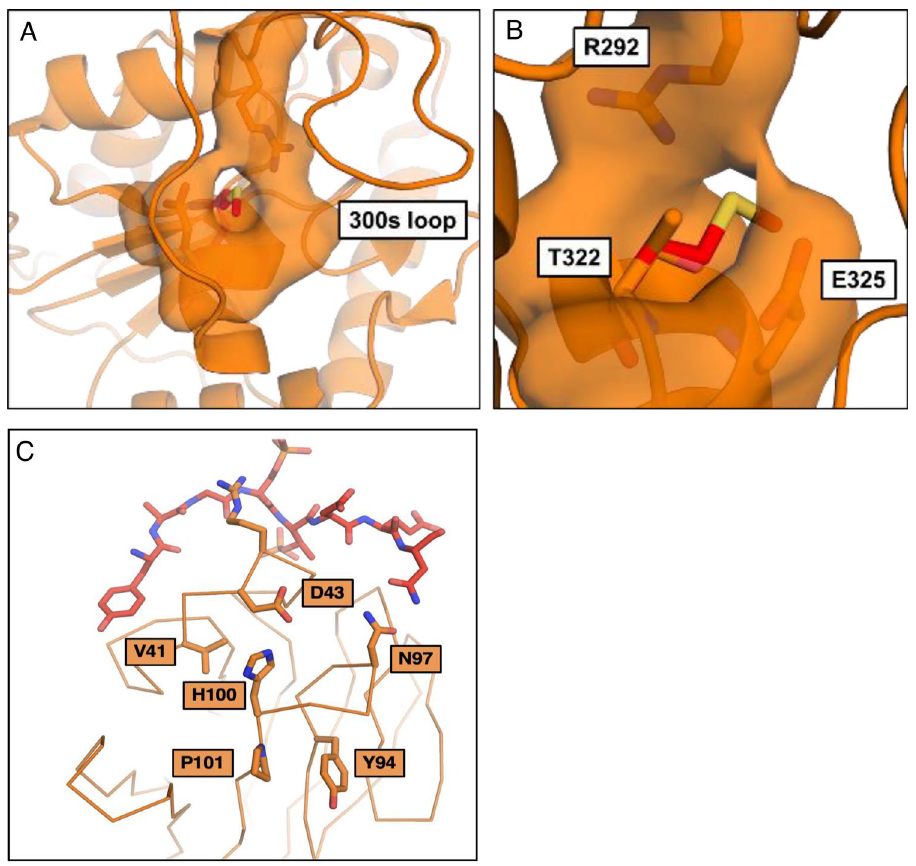
Figure 6. Local structures within PNKP at the sites of the amino acid changes. ( A , B ) Images taken from murine PNKP surrounding T322 (T323 in human PNKP). The mutation T322M appears to be minimally disruptive despite the larger size of methionine, due to the presence of a pocket that can accommodate the extended amino acid. However, potential clashes can occur with Glu 325 and Arg 292 (Glu 326 and Arg 293 in human PNKP). ( C ) An alignment of the FHA domain of human PNKP with the phosphopeptide binding site of XRCC4. The PNKP FHA domain is shown in orange and the XRCC4 pThr/pSer peptide is shown in red (PDB: 2W3O). A disruption in the P101/Y94 loop that causes a conformational change will affect His 100 which would affect the pThr binding interface through packing with V41 and D43. Additionally, movement in the P101/Y94 loop would affect direct binding to the pThr peptide through N97’s hydrogen